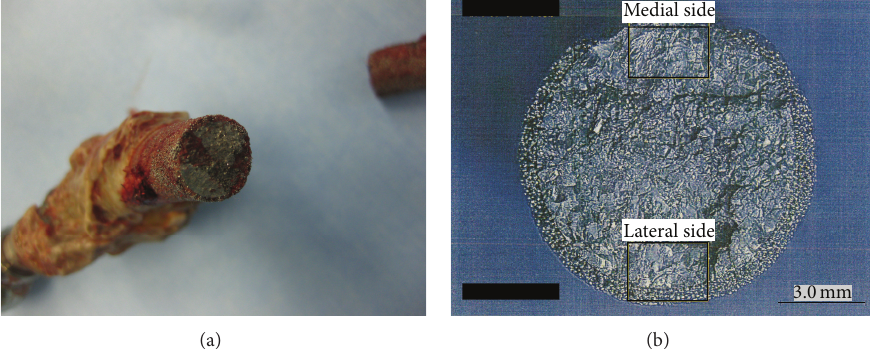
Figure 3: (a) The picture of retrieved implant. Lower left is medial side of the implant. (b) Extended section picture of proximal part. There was a clear step in the medial side, suggesting that lateral side was the starting point of fracture and medical side was lastly fractured.